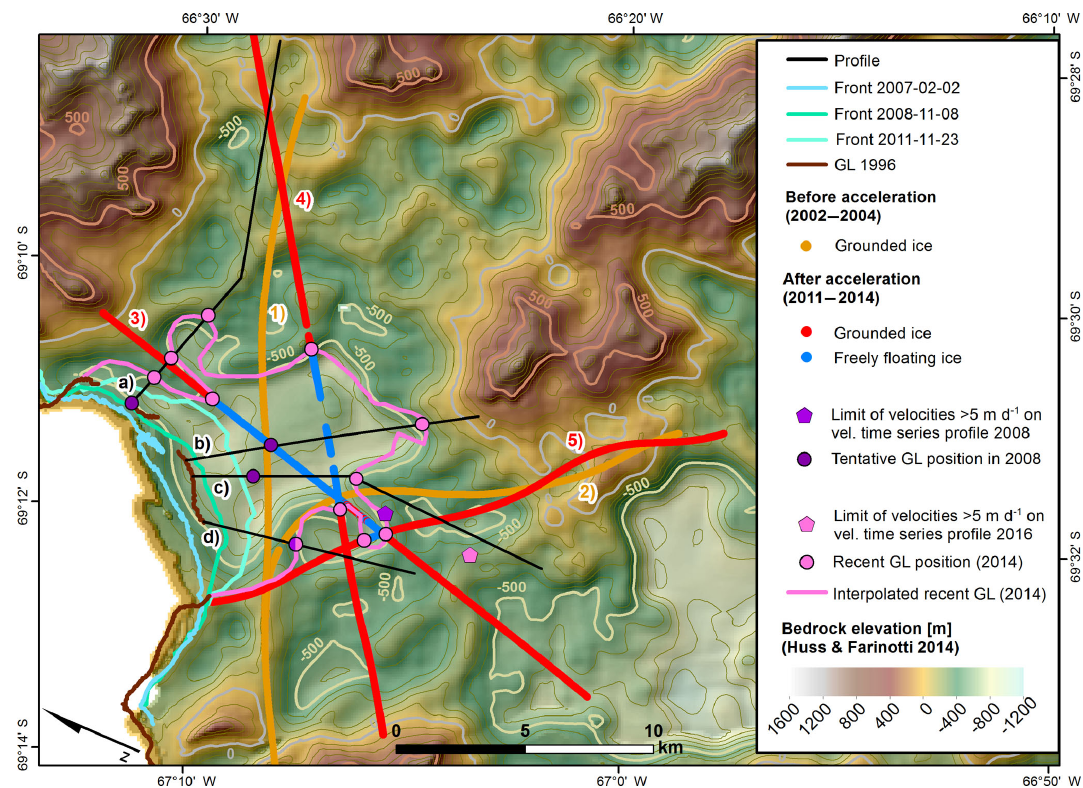
Figure 6. Floating area of Fleming Glacier and estimation of the recent grounding line. Black lines (a–d): profiles for extraction of modelled bedrock elevations, surface velocities and elevation change rates (see Fig. S6a–d). Elevation contours are shown at an interval of 100m. Light blue and cyan lines: glacier fronts on 2 February 2007, 8 November 2008 and 23 November 2011. Brown line: grounding line in 1996 (Rignot et al., 2005, 2011a). Orange dots: grounded ice before acceleration as derived from PIB lidar and ice thickness data. Dates of PIB flights: (1) 26 November 2002, (2) 18 November 2004. Background: bedrock elevation from Huss and Farinotti (2014). Blue and red dots: freely floating and grounded ice after acceleration as derived from OIB laser altimeter and ice thickness data. Dates of OIB flights: (3) 17 November 2011, (4) 16 November 2014 and (5) 10 November 2014. Purple pentagon: location of the limit of velocities > 5md − 1 on the velocity time series profile in 2008 (Figs. 1 and 2). Purple circles: tentative grounding line positions in 2008. Pink pentagon: location of the limit of acceleration on the velocity time series profile in 2015 (Figs. 1 and 2). Pink circles: estimated positions of the recent grounding line (2014) obtained from buoyancy calculations, surface velocities, elevation change rate patterns and/or modelled bedrock elevations on profiles a–d. Pink line: final solution of the interpolated recent (2014) grounding